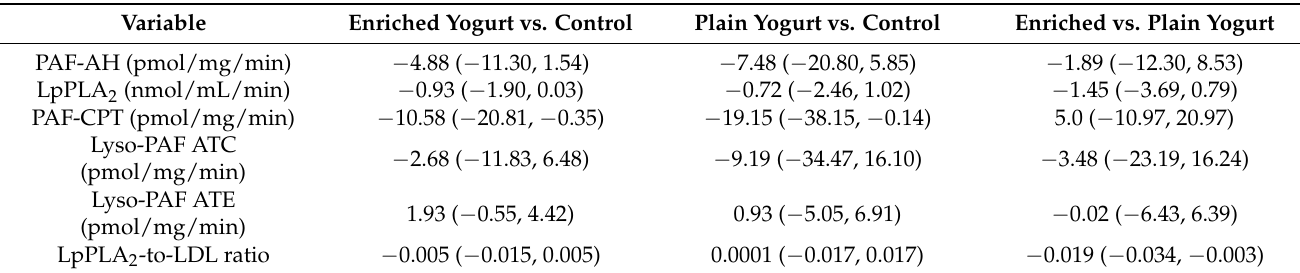
Table 5. Estimation of the difference in the enzyme activities between the intervention groups evaluated at week 8 of the